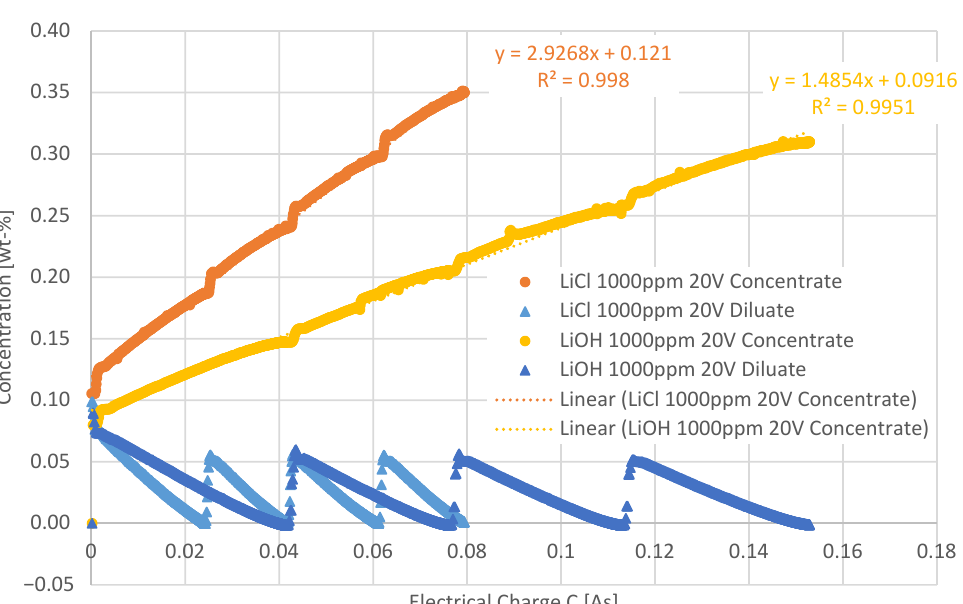
Figure 4. CE as a function of the concentration of LiCl in an aqueous solution for varying voltages at ϑ = 21 °C.